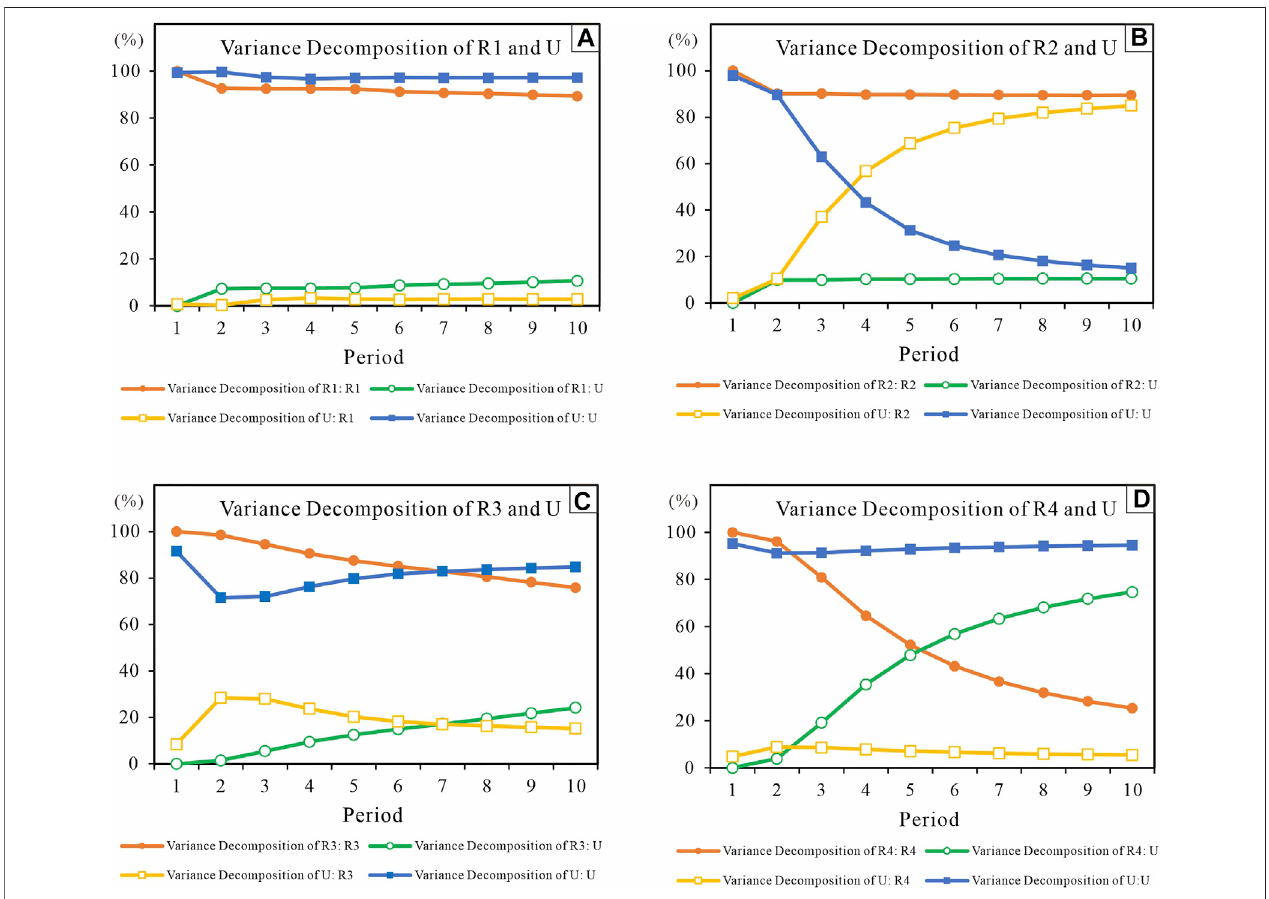
FIGURE5| DiagramsshowvariancedecompositionofwaterresourceandnewurbanizationforR1andU (A) ,R2andU (B) ,R3andU (C) andUtoR4 (D) .Dataare given in Supplementary Table S3 .